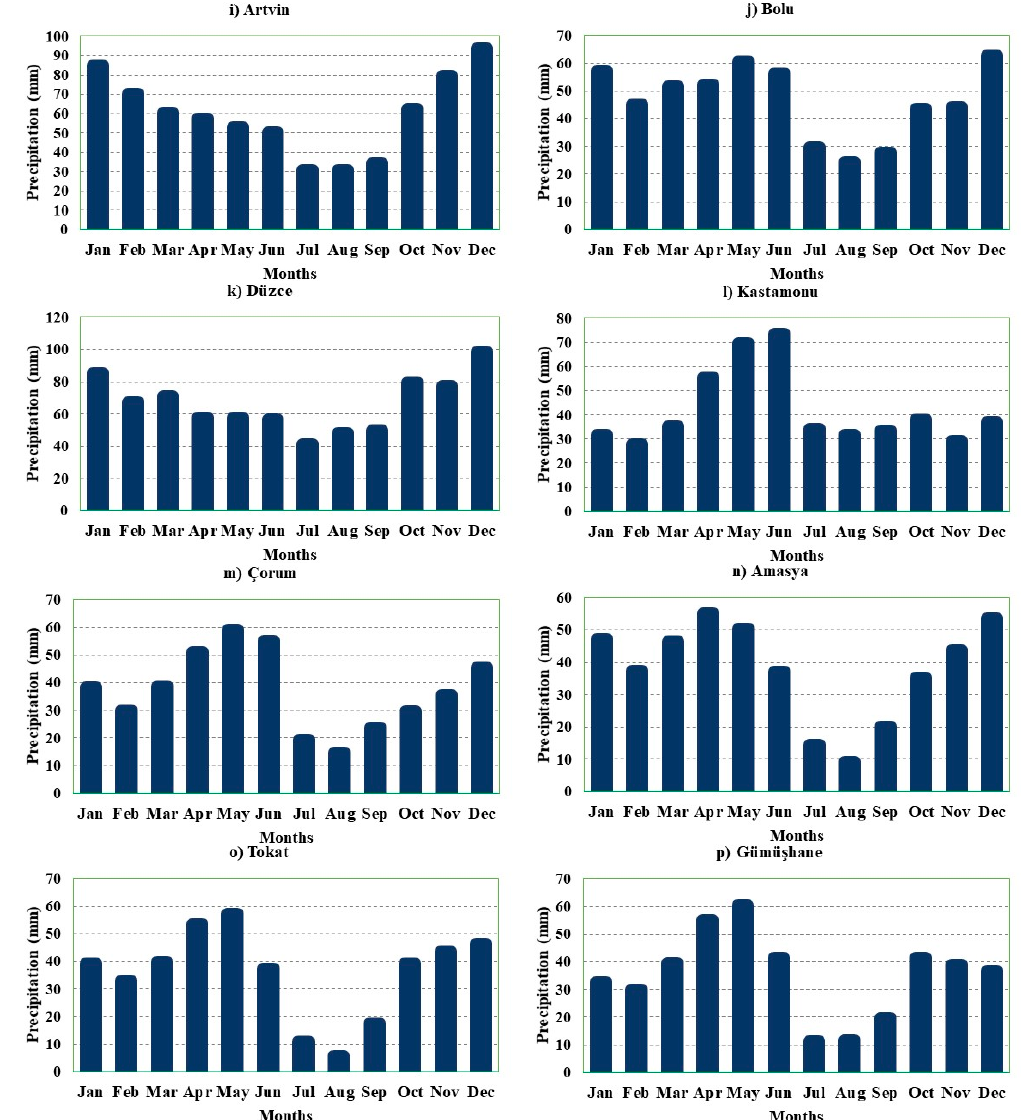
Figure 2. Histograms of the monthly precipitations for the stations under study.